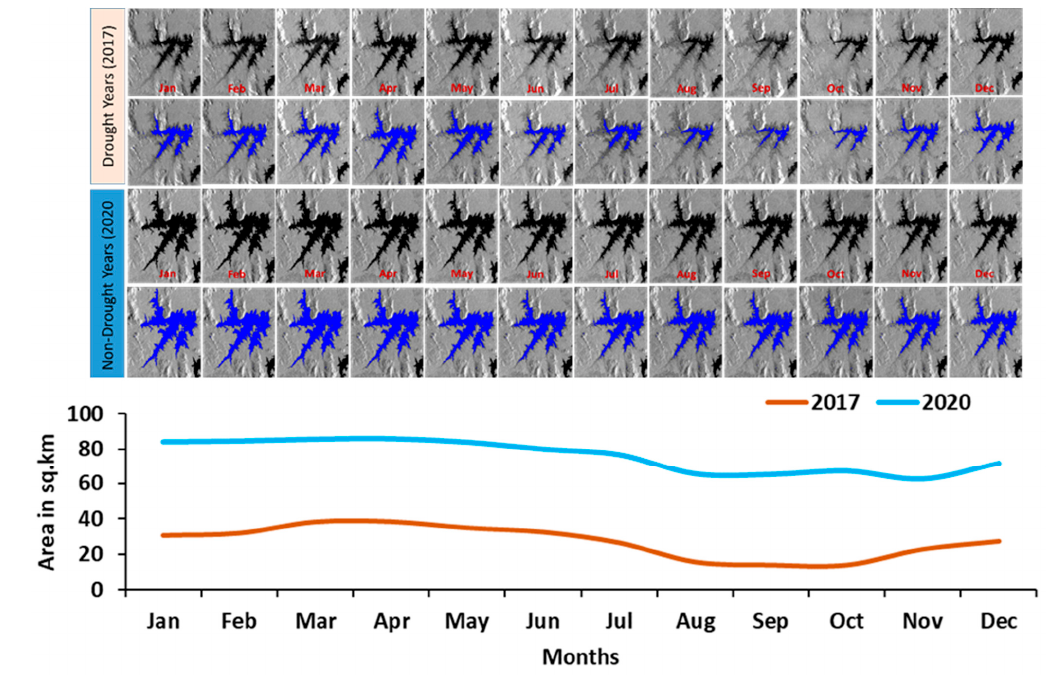
Figure 5. Water surface area changes through drought years and non-drought years (Tank D—Senanayaka Samudraya).